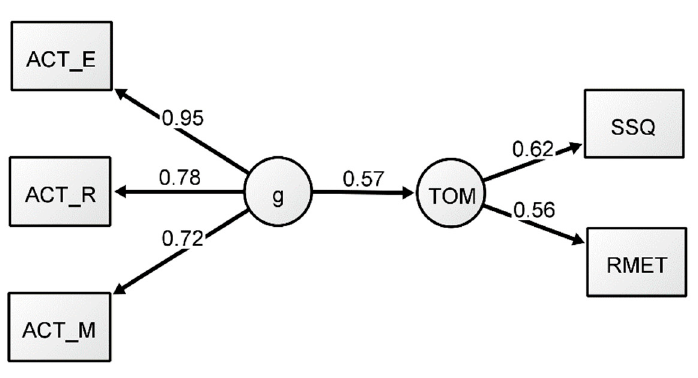
Figure 1. Reflective- g SEM Model 1. All coefficients presented are